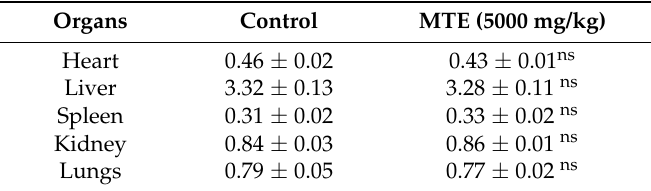
Table 1. The relative organ weight of rats treated with a single dose of Marsdenia tenacissima extract (MTE) for 14 days.